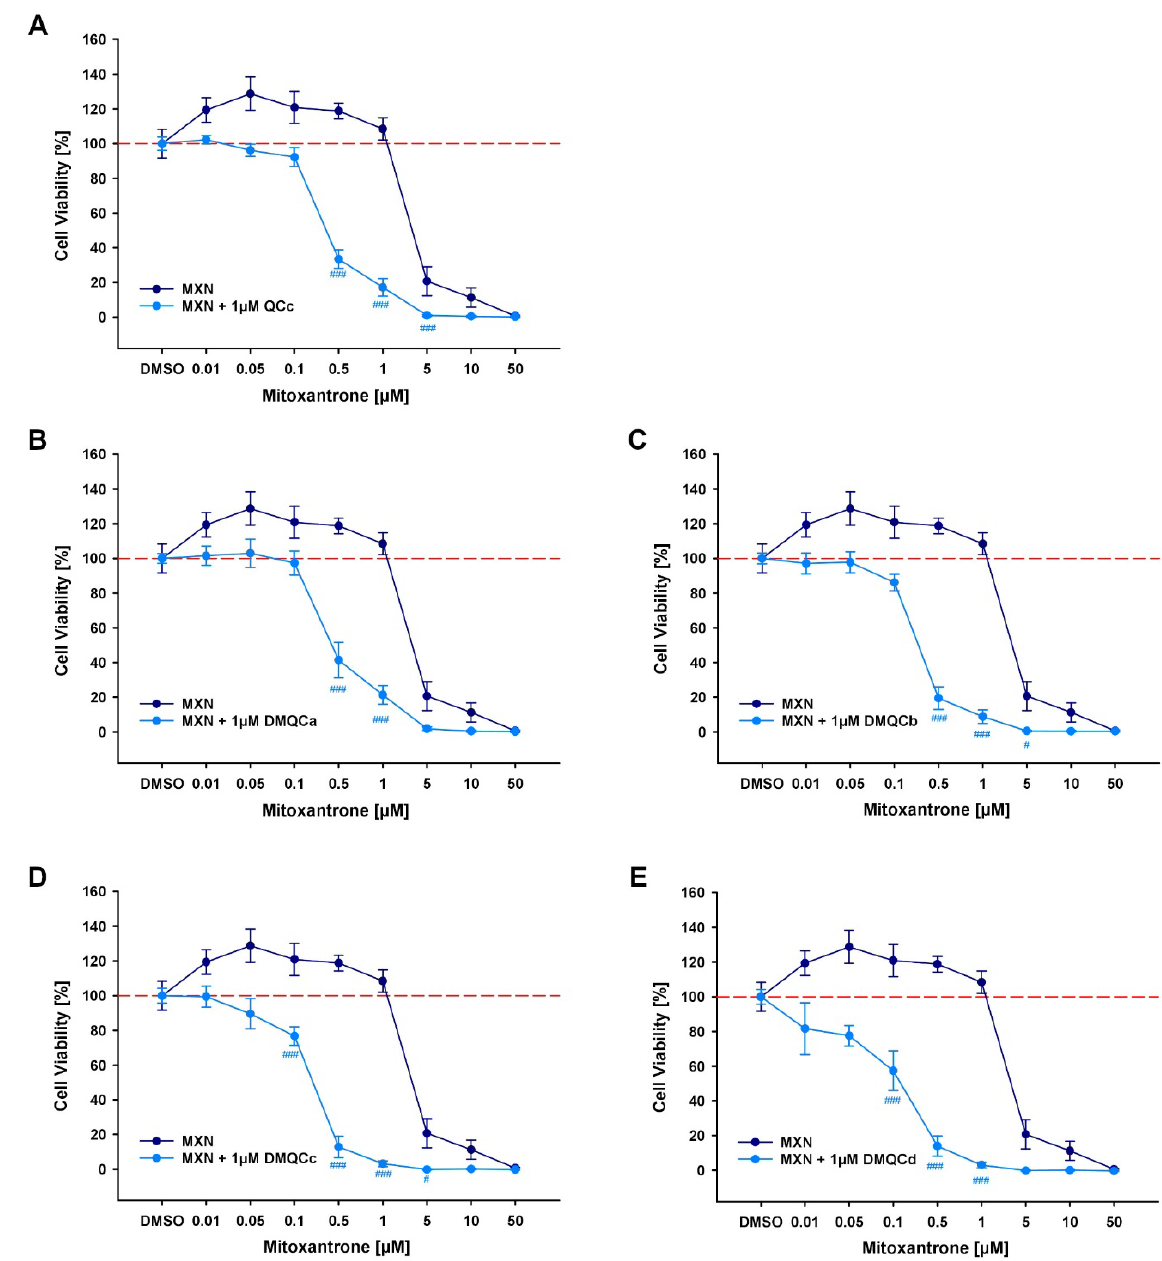
Figure 3. Reversal of ABCG2-mediated mitoxantrone (MXN) resistance of MDCKII-hABCG2 cells by 1 µM of ( A ) QCc , ( B ) DMQCa , ( C ) DMQCb , ( D ) DMQCc , and ( E ) DMQCd . MDCKII cells were